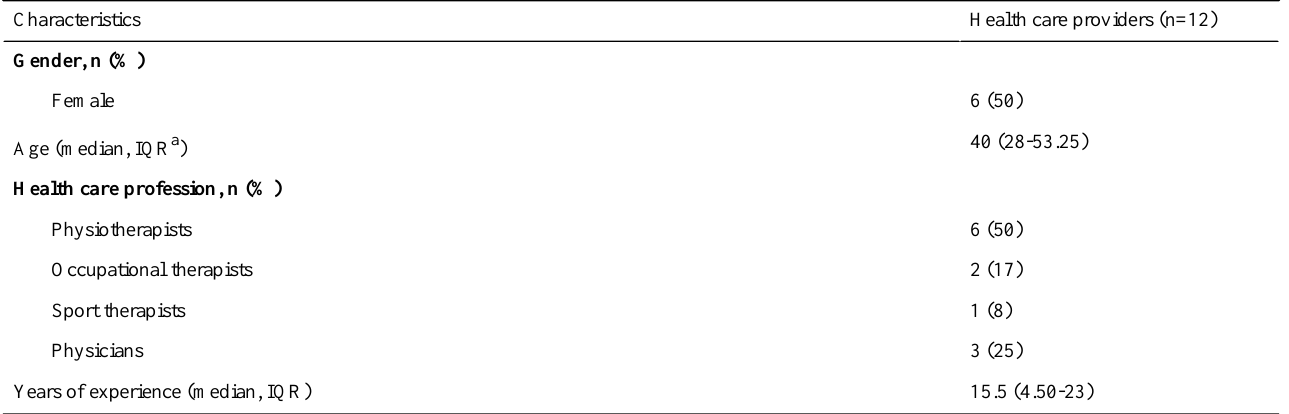
Table 2. Participant characteristics: health care providers.